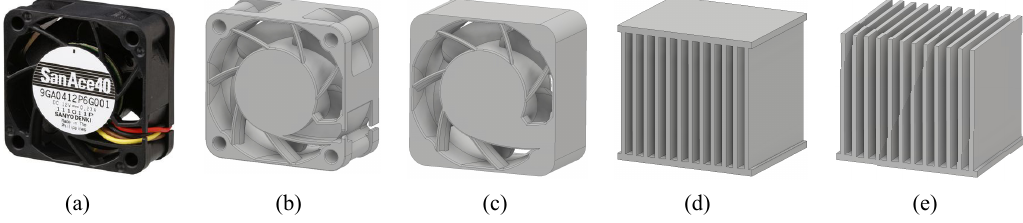
Figure 6. A commercial fan, Sanyo Denki 9GA0412P6G001, and a manually designed heat sink; ( a )